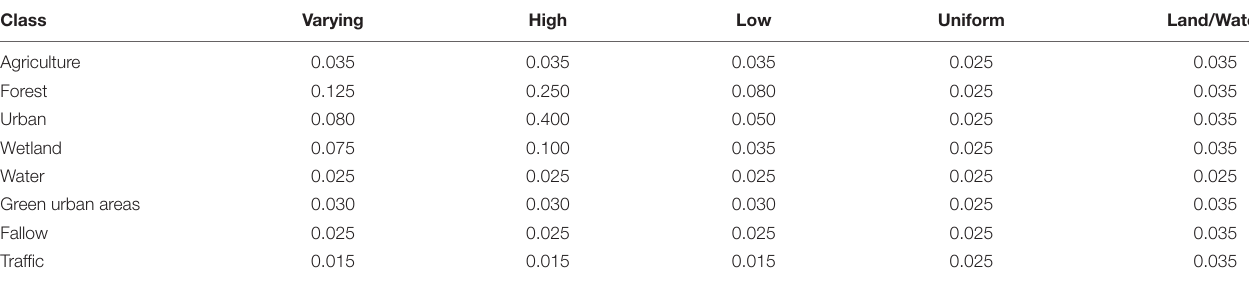
TABLE 2 | Manning’s roughness coefficients for land use